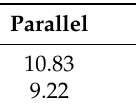
Table 2. Error rate of add